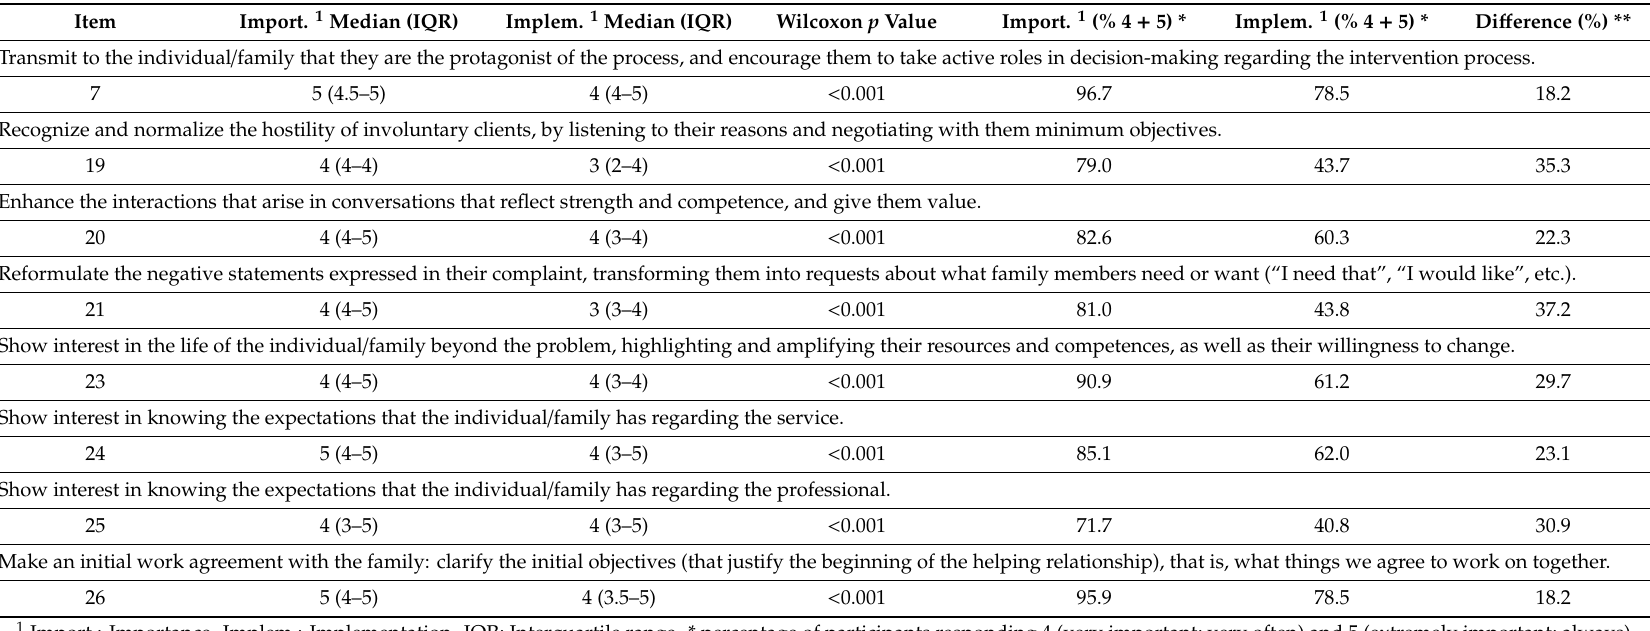
Table 7. Factor VI: assessment of family